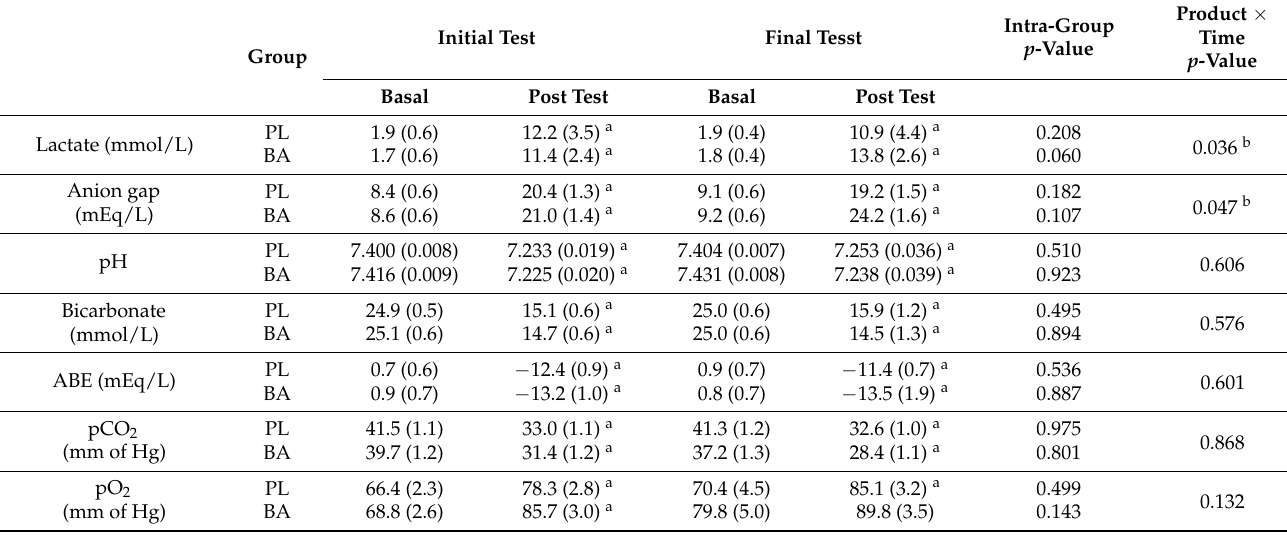
Table 3. Physiological responses: microcapillary blood biochemical analysis. Values are presented as mean with standard error of the mean (between